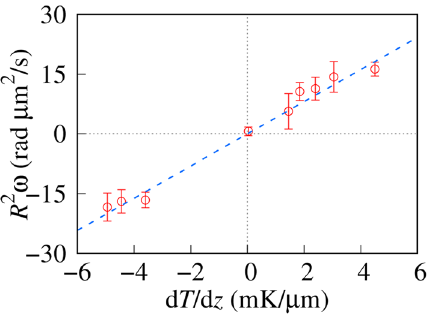
Figure 2. Temperature gradient dependence of the normalized angular momentum. The dashed line is the best-fit curve obtained using Eq. (1). The slope of the fitting function is 4.0 rad µm 3 /mK s. Each data point is averaged over more than 4